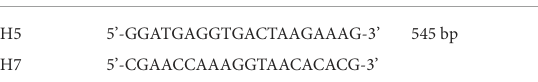
(Figure 3). Phylogenetic analysis of the gag genes revealed two distinct branches: gag regions of HB2020 clustered with ev-1, and the ALV prototype HPRS-103 clustered with Rous sarcoma virus (strain Prague C) (RSV-PrC) and Schmidt-Ruppin D strain of RSV (SR-RSV-D(H) (Figure 4B). The genes and functional regions (LTR, pol , gp85 , and gp37 ) of HB2020 and HPRS-103 were found in the same branch in their respective phylogenetic trees (Figure 4). The analysis of recombination events revealed that the major recombination sites of HB2020 and ev-1 were located in gag regions (Figure